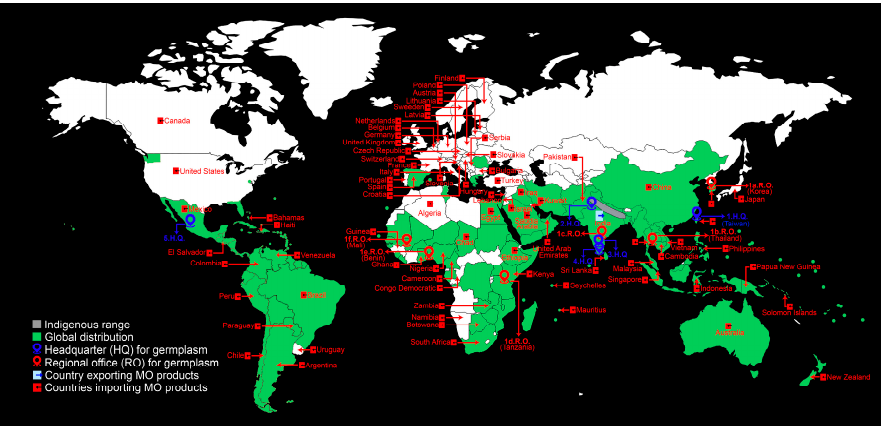
Figure 1. Global distribution of MO (native and/or naturalized), centers for germplasm conservation, and countries importing Moringa products from